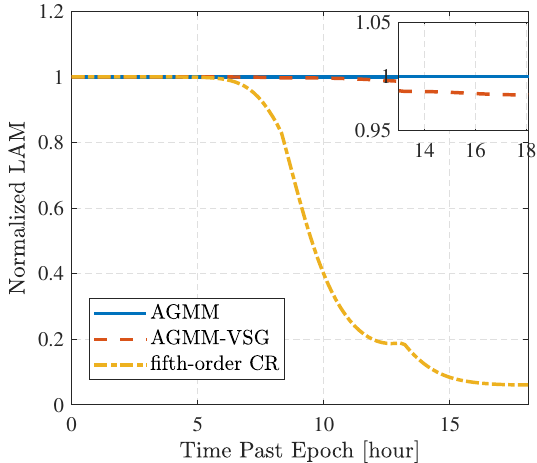
Figure 5. Likelihood agreement measure for the AGMM, AGMM-VSG, and fifth-order CR of HEO